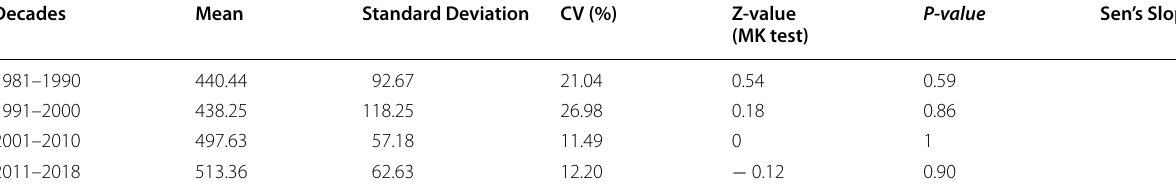
Table 7 Descriptive statistics and test results of decadal rainfall (1981–2018) Decades Mean Standard Deviation